Question: What form of chart is displayed?
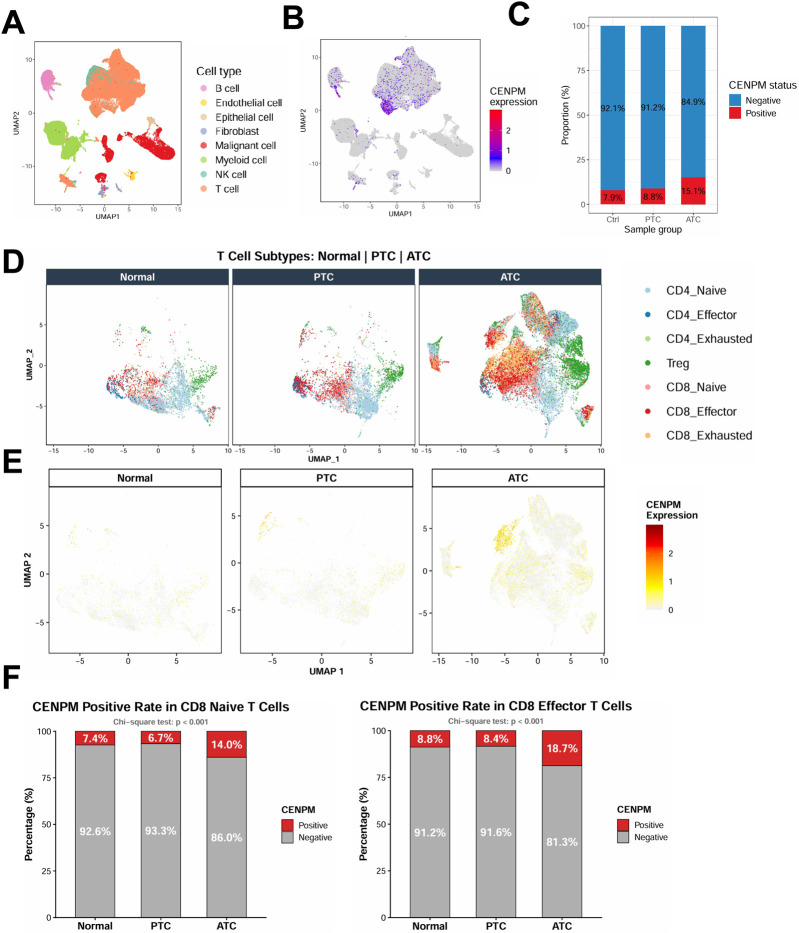
Answer: scatter